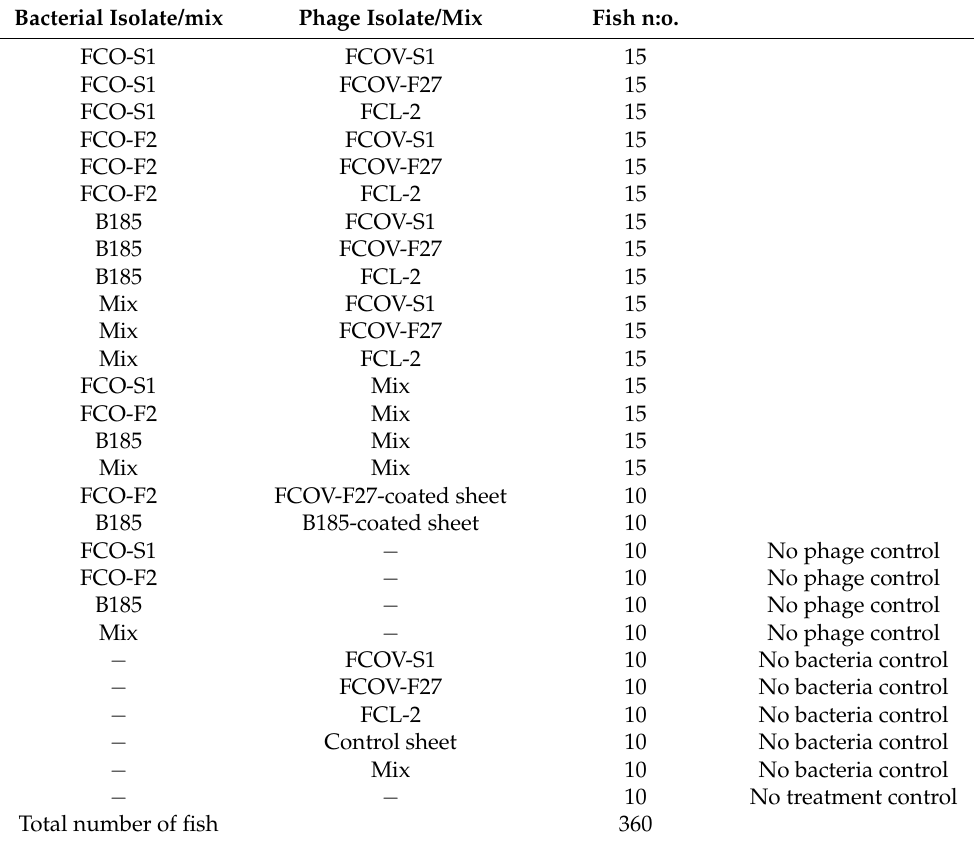
Table 2. Setup of experiment I. Rainbow trout fry were infected individually with three Flavobacterium columnare isolates (FCO-S1, FCO-F2, and B185) (5 × 10 3 CFU mL − 1 ) and their mix. For phage treatment, purified phages (FCOV-S1, FCOV-F27, and FCL-2) (MOI 1) or their mix were added 2 h after and phage-coated plastic sheets (FCOV-F27, FCL-2, and control without phage coating) just before adding the bacteria. − = Shieh medium added instead of bacterium and/or phage. Bacterial Isolate/mix Phage Isolate/Mix Fish n:o. FCO-S1 FCOV-S1